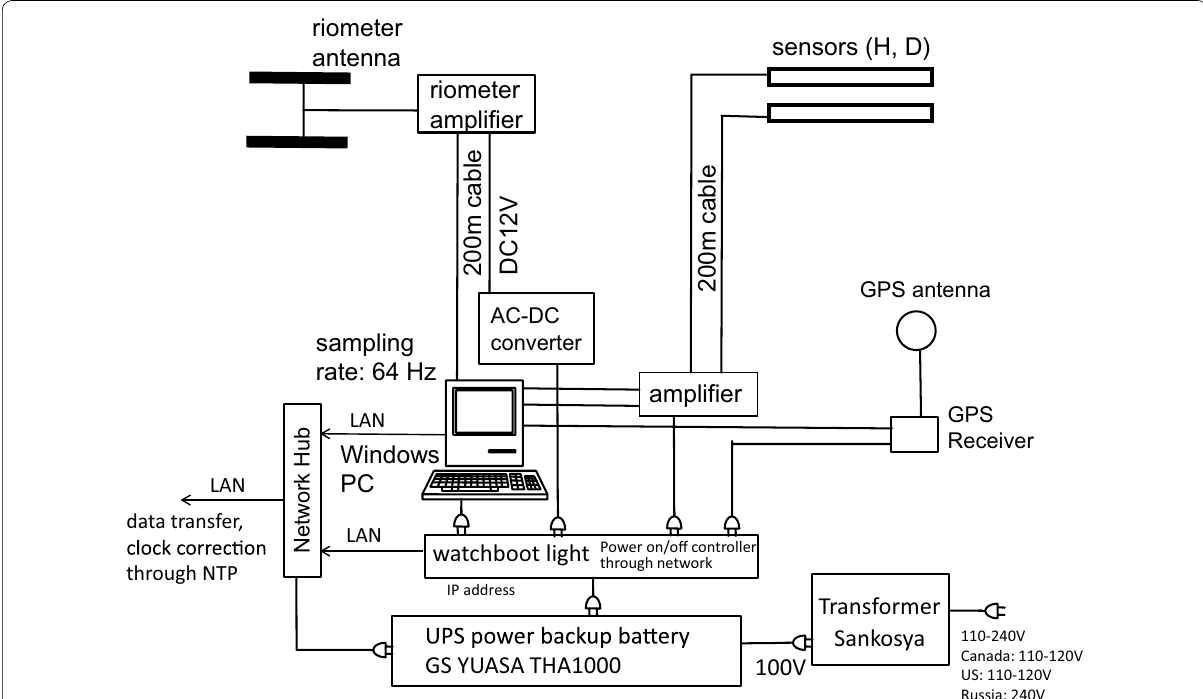
Fig. 6 Block diagram of the induction magnetometer and riometer